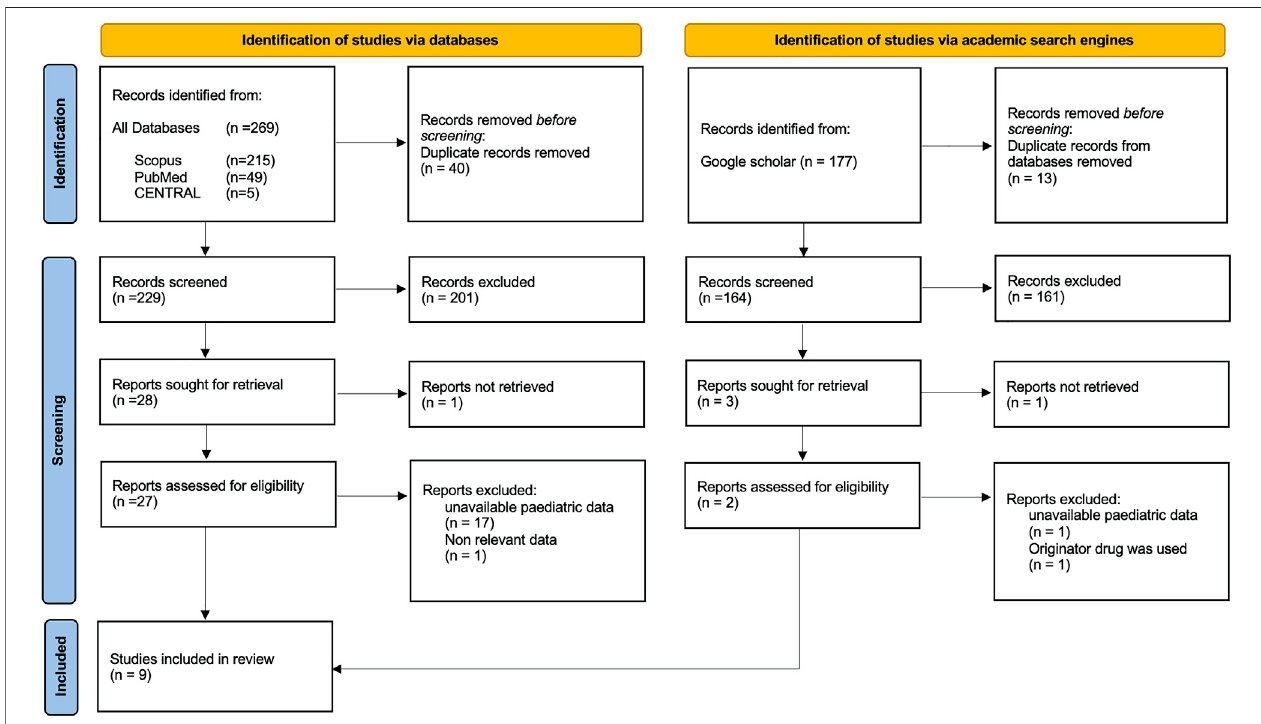
FIGURE 1 | Flow chart for study retrieval and